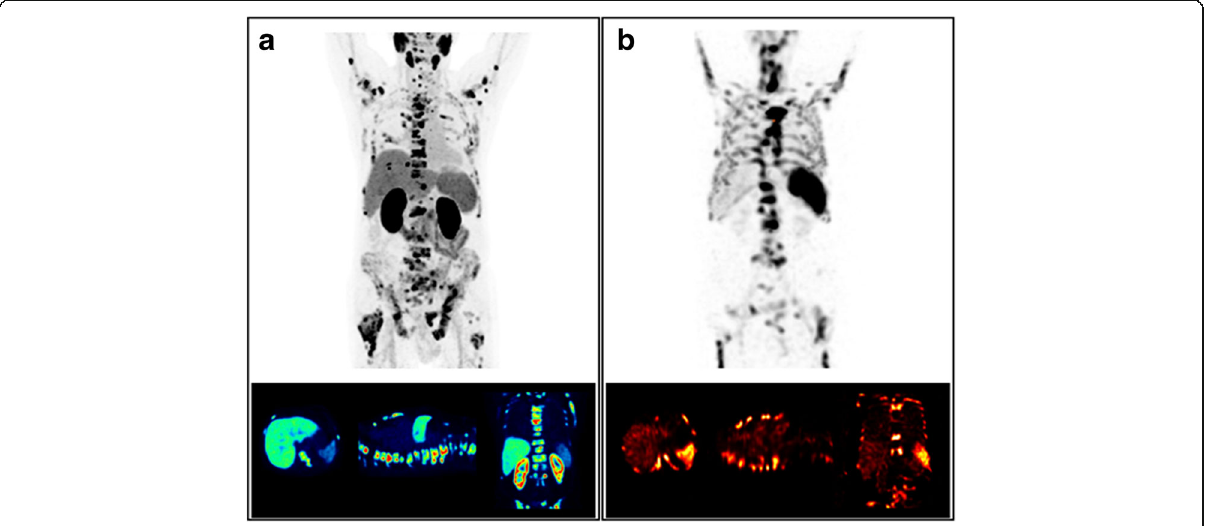
Fig. 5 Results from Tc-99m-anti-granulocyte antibody SPECT/CT ( b ) in comparison to the Ga-68- PSMA-11 PET/CT ( a ) for patient